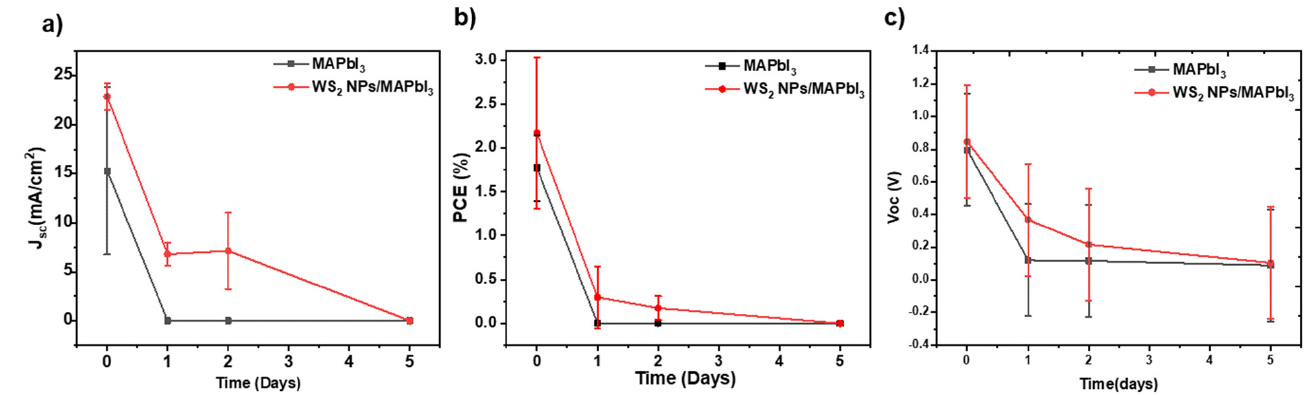
Figure 6. ( a ) J-V characteristic, ( b ) PCE and ( c ) V oc of MAPbI 3 and WS 2 NPs/MAPbI 3 PSCs for different days. Table 1. Photovoltaic parameters of the devices without (MAPbI 3 ) and with WS 2 NPs (WS 2 NPs/MAPbI 3